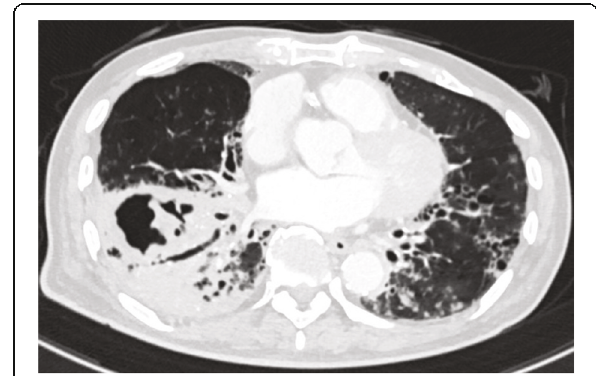
Fig. 1 The chest CT lung window imaging shows bilateral bronchiectasis and a large bulla with surrounding consolidation in the right lower lobe